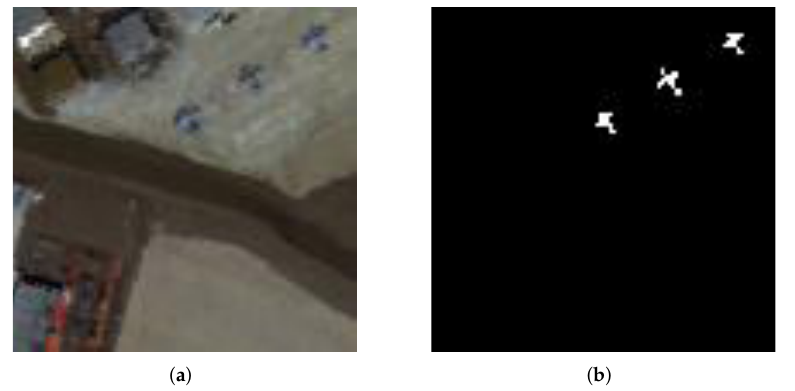
Figure 7. Sandiego dataset and anomaly background response diagram. ( a ) Pseudo-color image. ( b ) Ground-truth